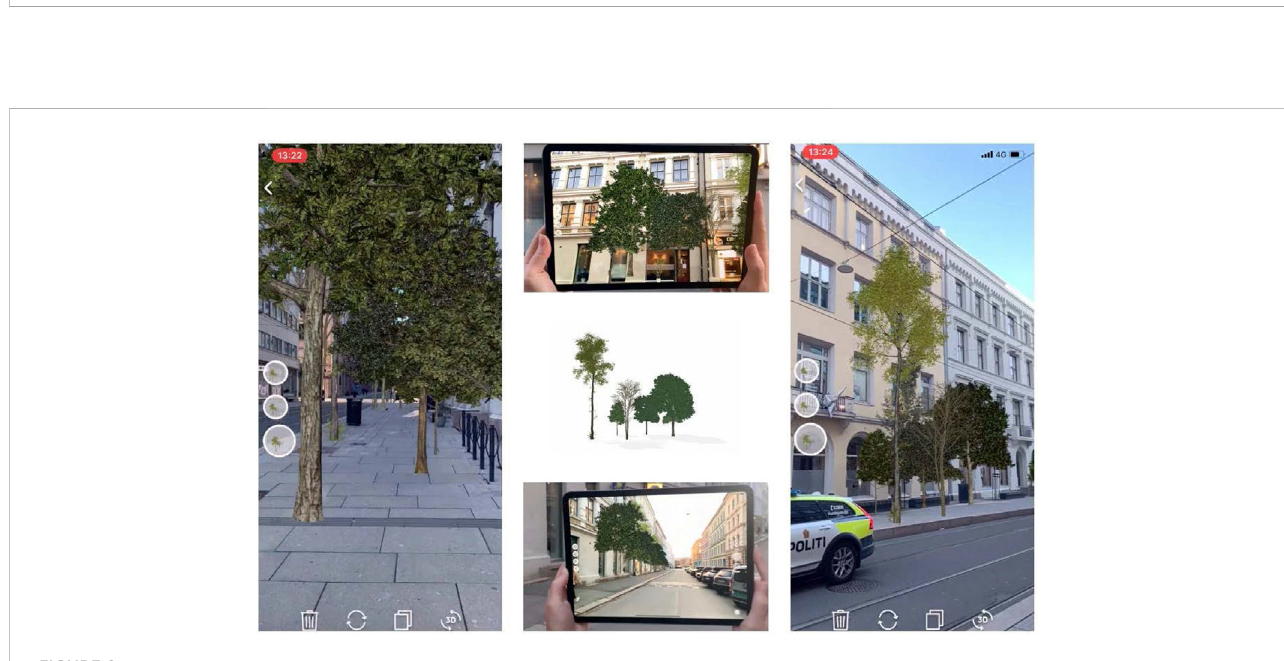
FIGURE 9 The original proposal made for Oslo